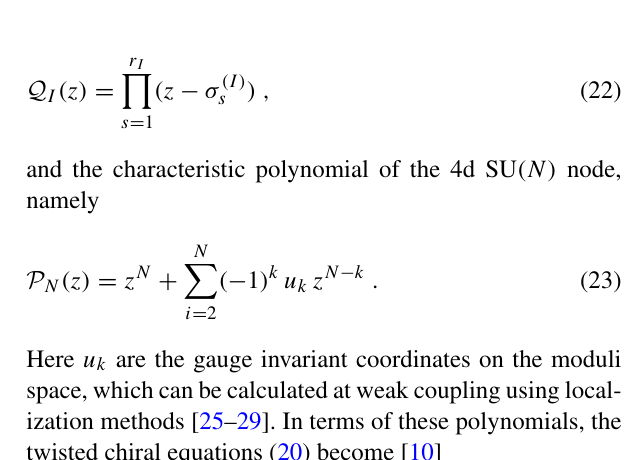
Fig. 2 The 4-node linear quiver that corresponds to the partition [